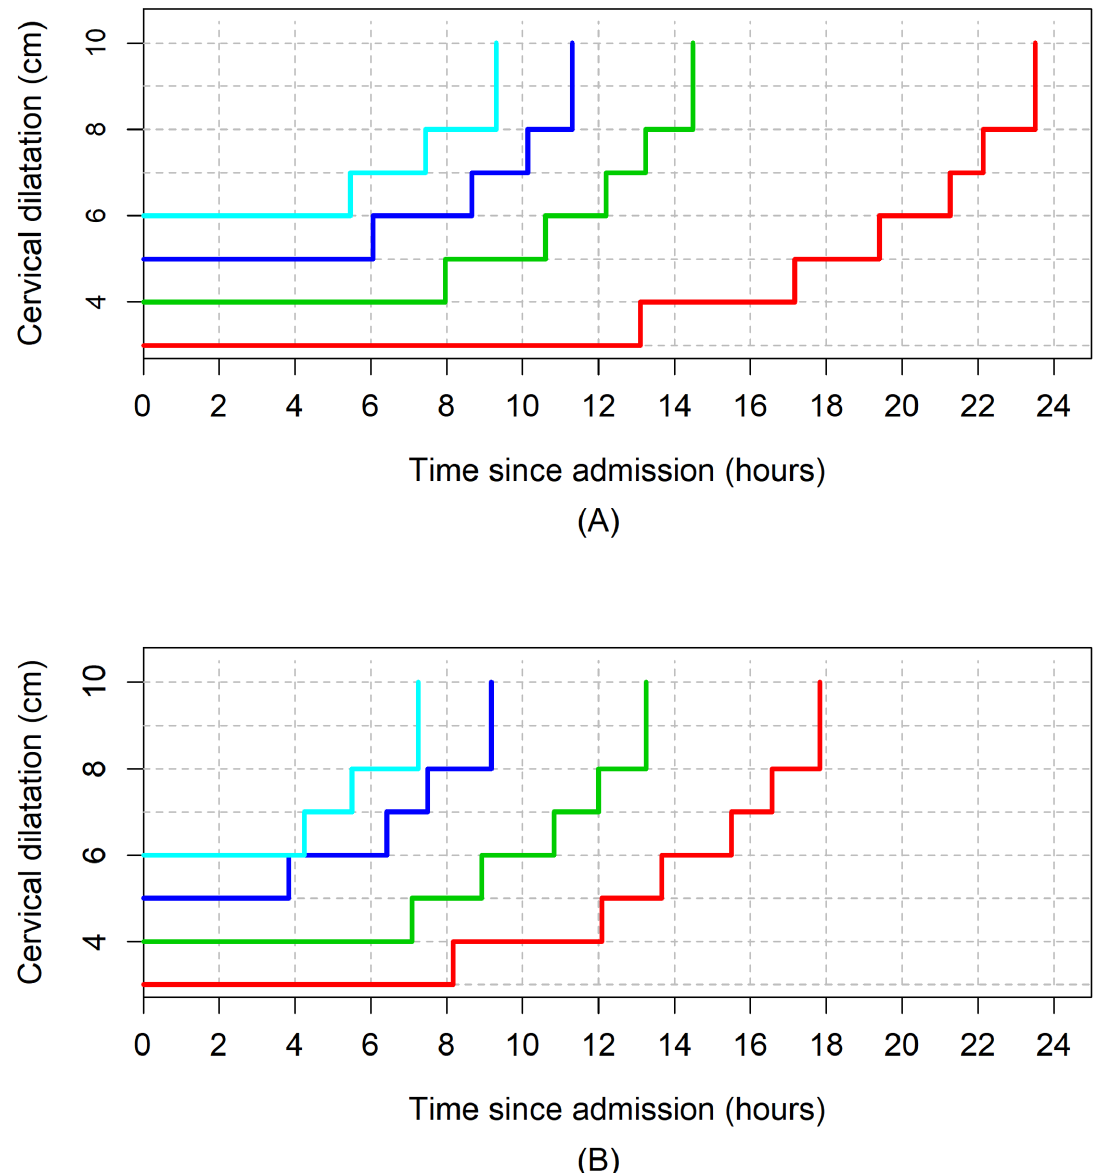
Fig 3. The 95th percentiles of cumulative duration of labour among nulliparous women. (A) Survival analysis. (B) Multistate Markov